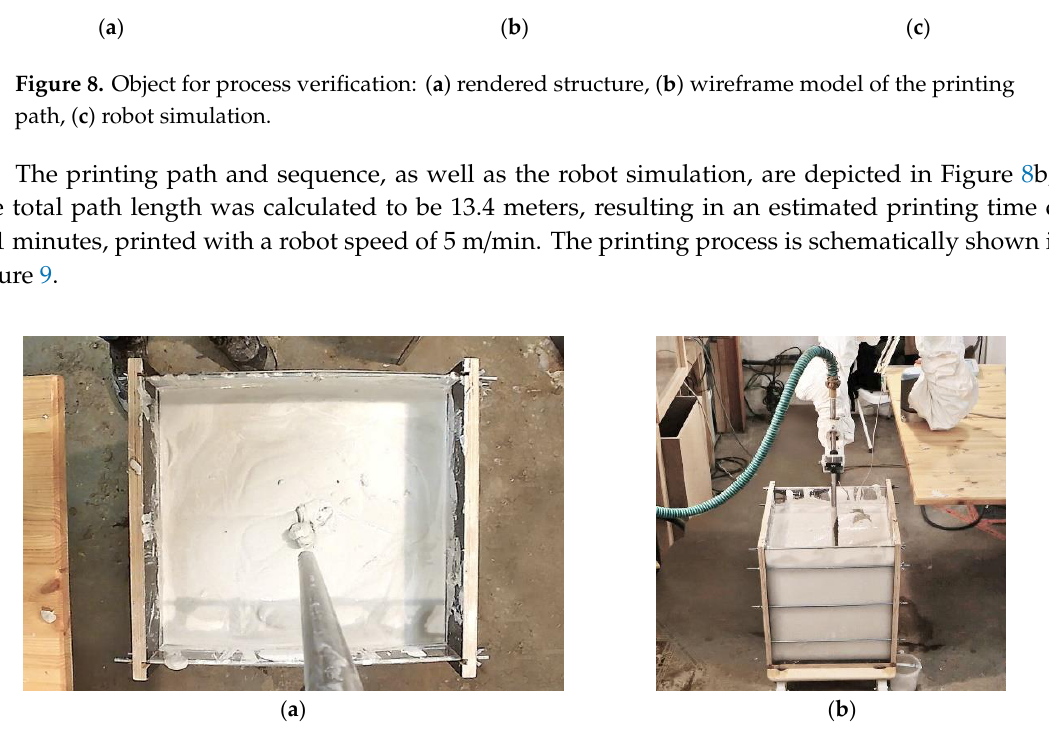
Figure 8. Object for process verification: ( a ) rendered structure, ( b ) wireframe model of the printing path, ( c ) robot simulation.